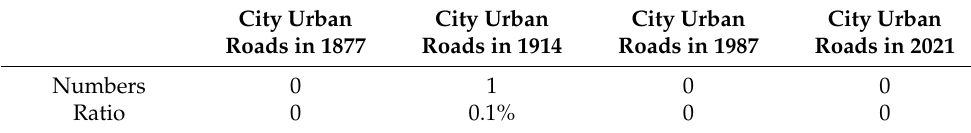
Table 2. Road Points of Contact in the Changsha Historic Urban Area in Various